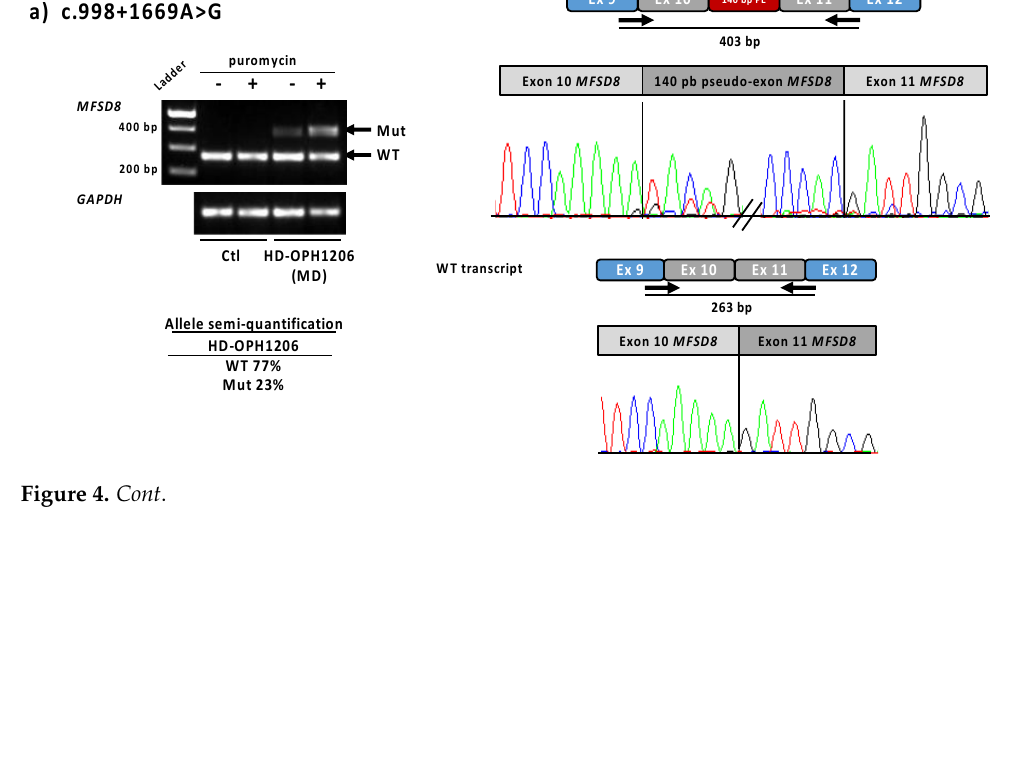
Figure 4. Functional tests results for MFSD8 variants c.998+1669A>G and c.750A>G in LCLs Lym- phoblastic cell lines from patients HD-OPH1206, L-08031428 and L-20021807 were used to analyse MFSD8 cDNA expression. ( a ) Overlapping primers located at the exons 9–10 and 11–12, respectively were used to show the inclusion of a 140 bp pseudoexon due to the c.998+1669A>G variant. On the right, electropherograms obtained from the upper and lower bands separated on agarose gel. ( b ) The exon 8 skipping due to c.750A>G variant was confirmed using primers located at exons 6–7 and 9–10 junctions. The exon 8 skipping is observed in control at a very low level, suggesting exon 8 as an alternative cassette, normally expressed, and enhanced by the presence of this variant. Semi- quantification of the bands (using primers located in exon 7 and 9) has been performed on cells not treated by puromycin. Ctl—control; MD—macular dystrophy; NCL—neuronal ceroid lipofushi- nose. In patient L-20021807, the second variant is a large deletion of exons 9 and 10, c.(755- 2726_998+1981)delinsGTA (Figure S3b). It was first detected by an NGS panel and then confirmed by whole-genome sequencing which defined the exact borders. This 7118 bp deletion leads also to a frameshift and therefore to a null allele. Repetitive elements were L-20021807 WT 25% Mut 75%L-08031428 WT 60% Mut 40%Allele semi-quantification